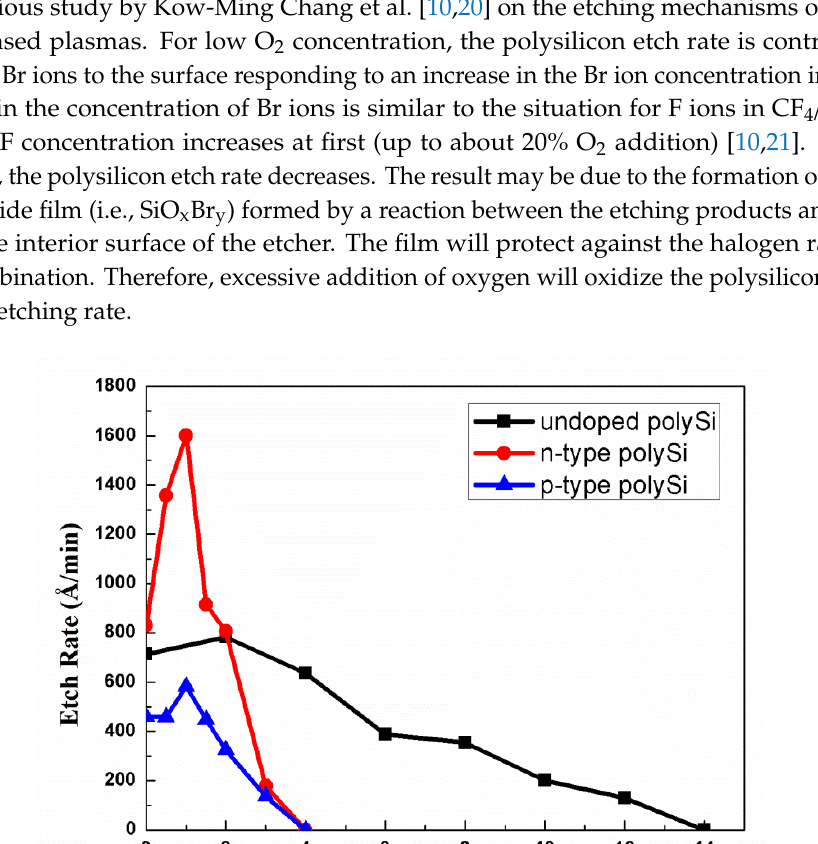
Figure 4. The compositions of three types of polysilicon film after etching measured by XPS.